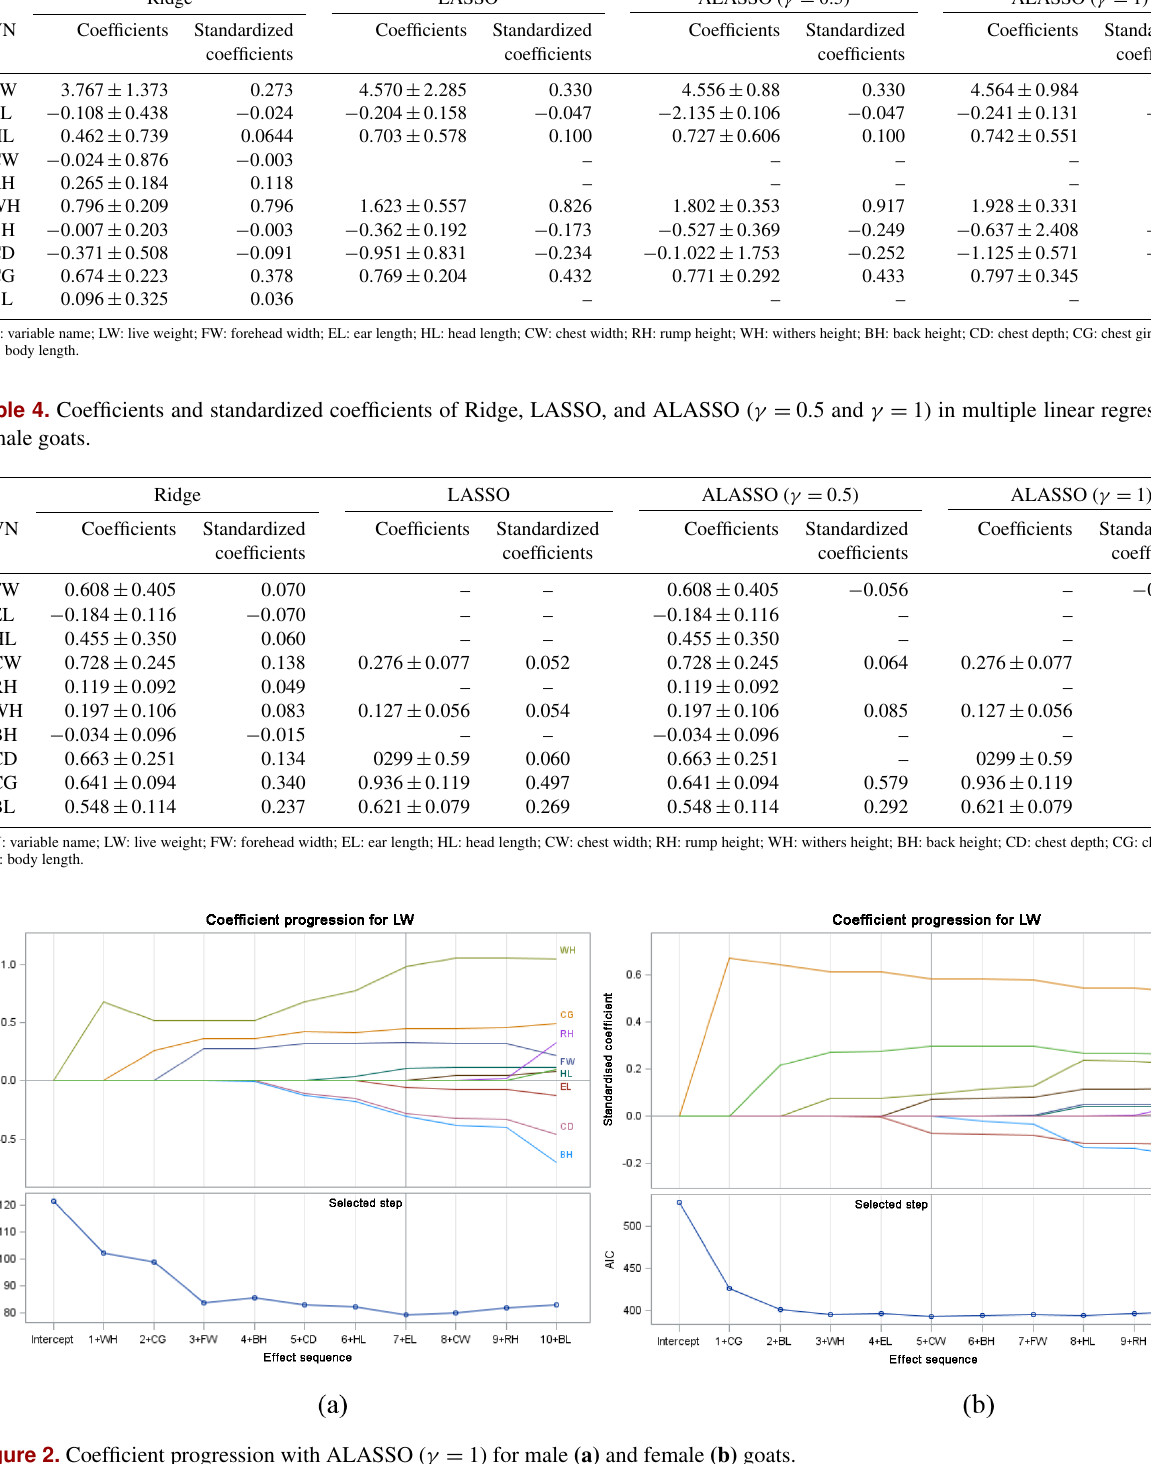
Figure 2. Coefficient progression with ALASSO ( γ = 1) for male (a) and female (b) goats.